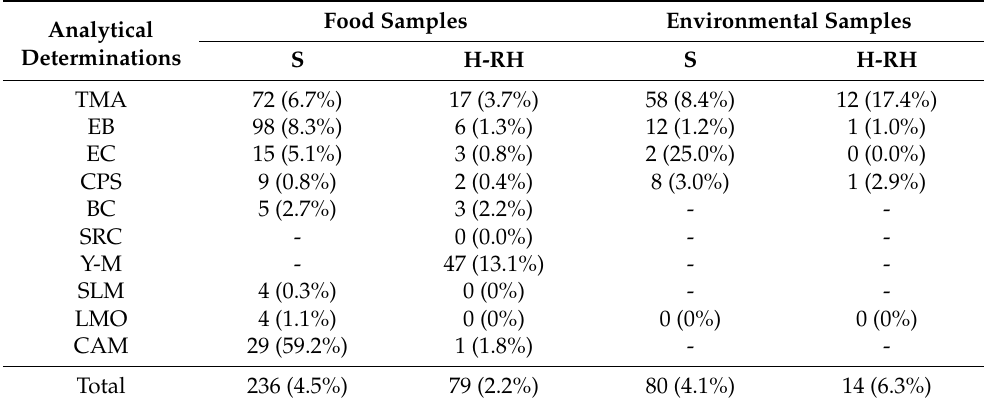
Table 5. Values and percentages * of non-compliant results for food and environmental samples for schools (S) and hospitals/retirement homes (H-RH).